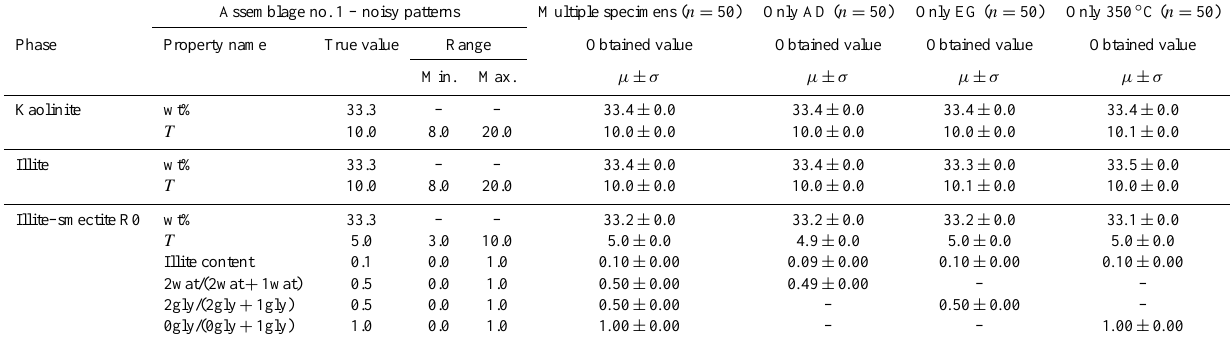
Table 6. Overview of the means and standard deviations of weight fractions and refined parameters for assemblage 1 using noisy patterns. Assemblage no. 1 – noisy